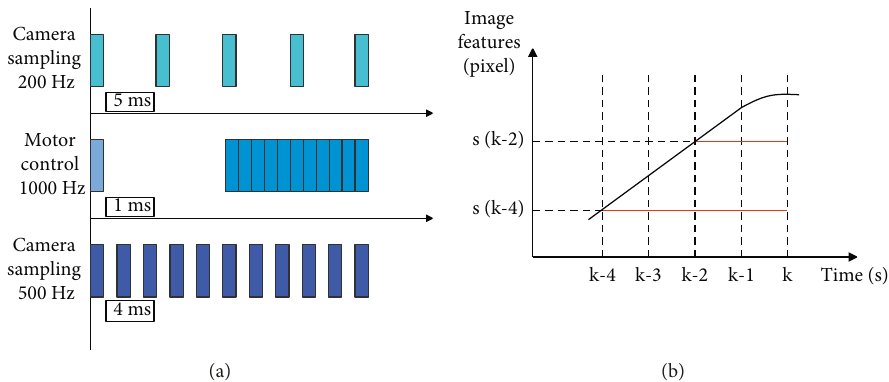
Figure 3: Feature time-series diagram of the visual servo control system. (a) Frequency difference chart and (b) feature timing